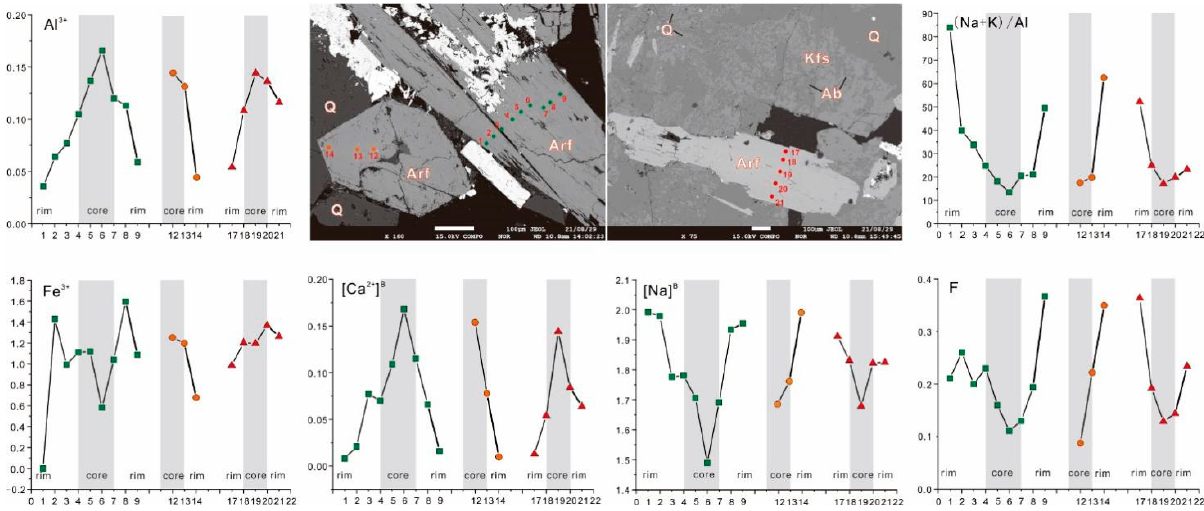
Figure 8. Rim–core cationic (apfu) profiles describing the main compositional variations in selected arfvedsonite of peralkaline miarolitic granite. The color in the rim–core cationic (apfu) profiles is consistent with that in BSE. Q = Quartz; Arf = Arfvedsonite; Kfs = K-feldspar.